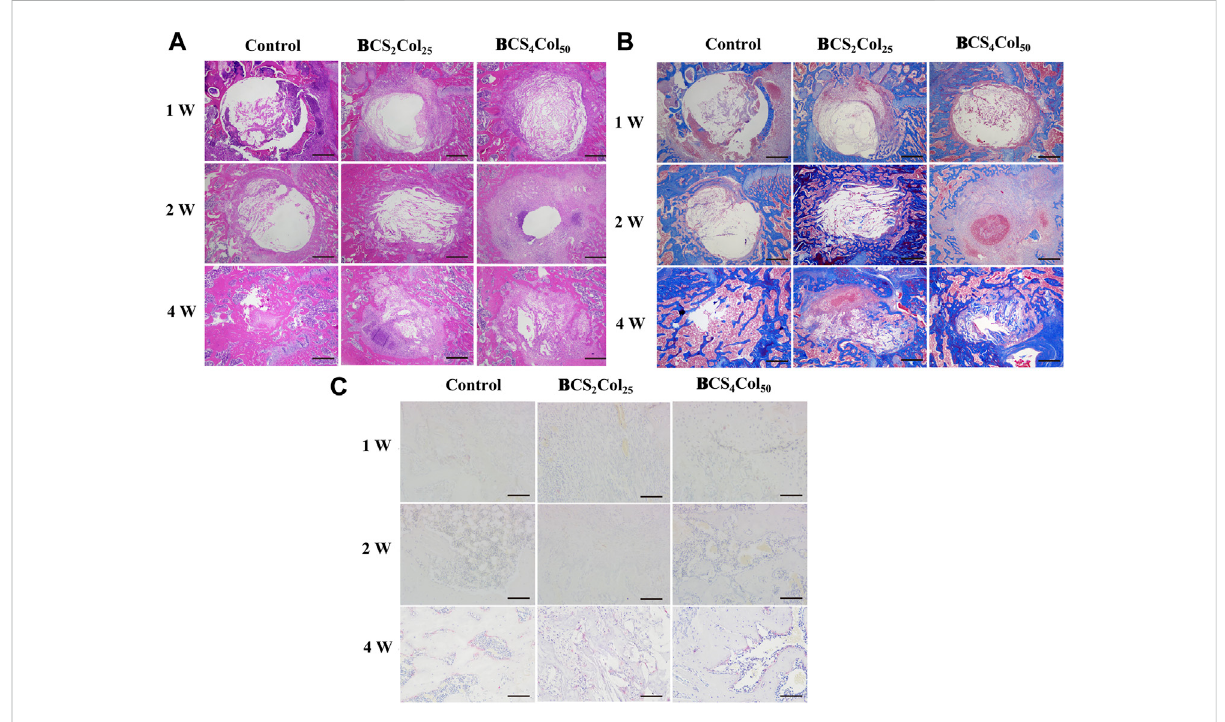
FIGURE 7 Representative images of H&E (A) , Masson ’ s (B), and TRAP (C) staining results after 1-, 2-, and 4-week operation. The scale bar of a and b is 500 μ m; The scale bar of C is 100 μ